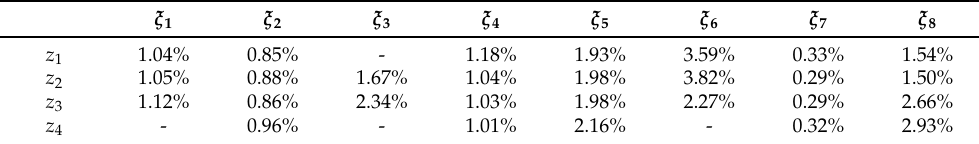
Table 11. Identified first eight modal damping ratios ξ i for the WPT position z 2 with the lowest number of found modes and the equivalent modes’ damping ratios at the other positions; “-” indicates that no matching mode with a MAC value of at least 80% was